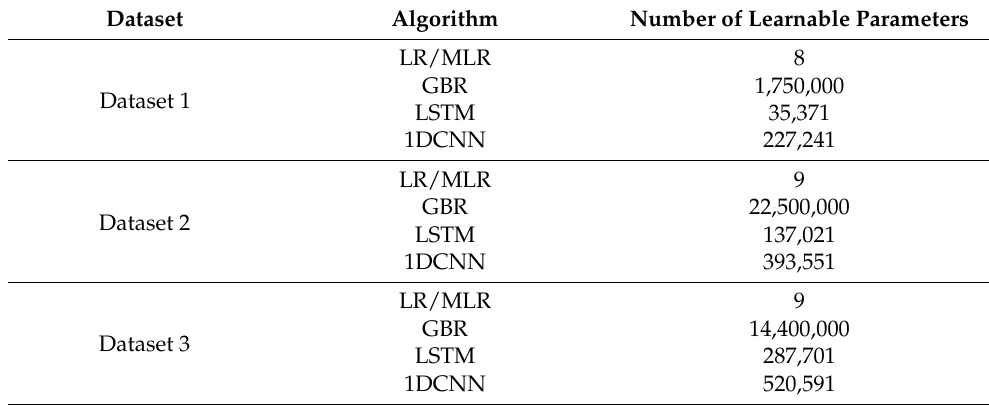
Table 5. The number of learnable parameters for GBR, LSTM, and 1DCNN in SC3 for TTS1.